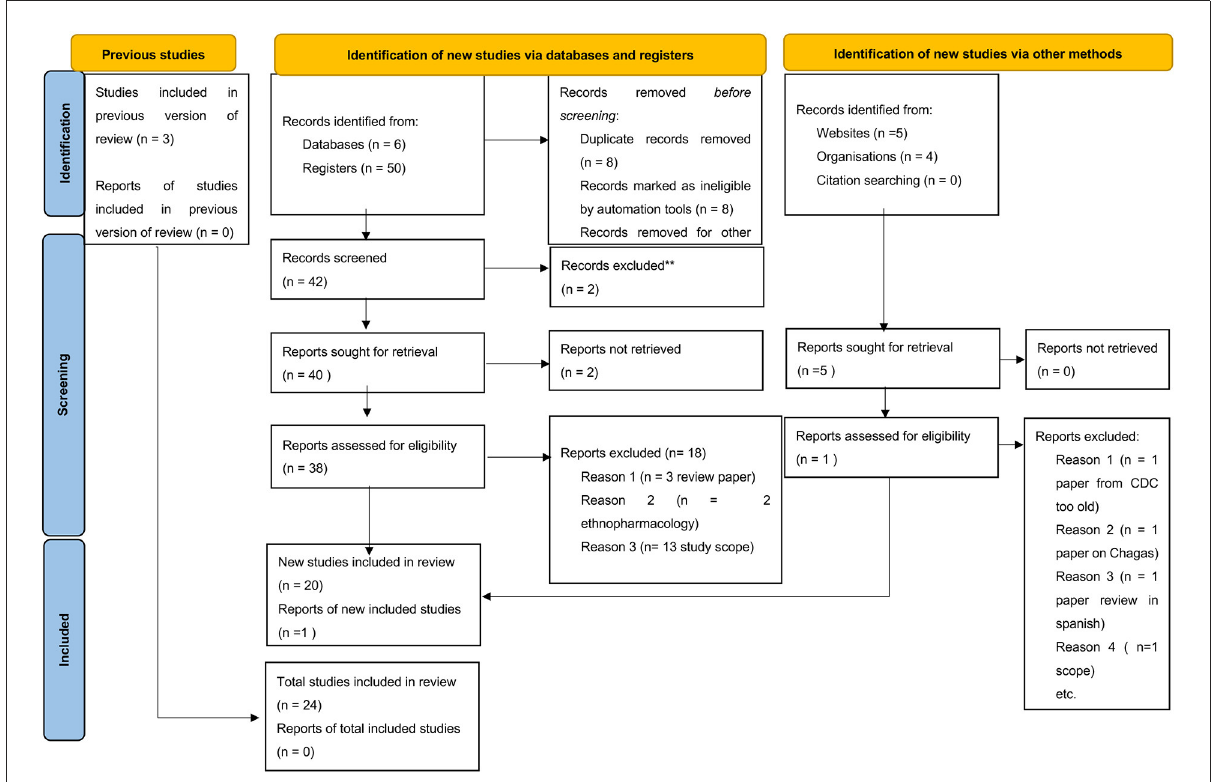
FIGURE1 PRISMA checklist showing searched databases, registries, google search directories, and publications included in the study.